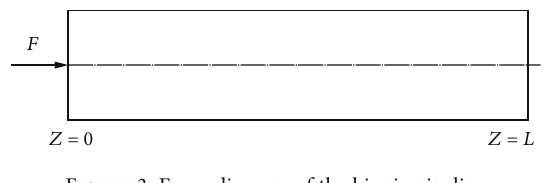
Figure 3: Force diagram of the bionic pipeline